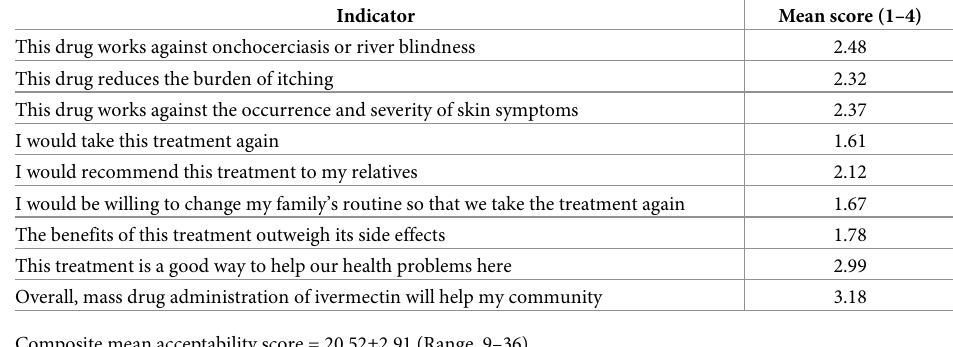
Table 4. Mean acceptability scores of ivermectin mass drug administration (N =